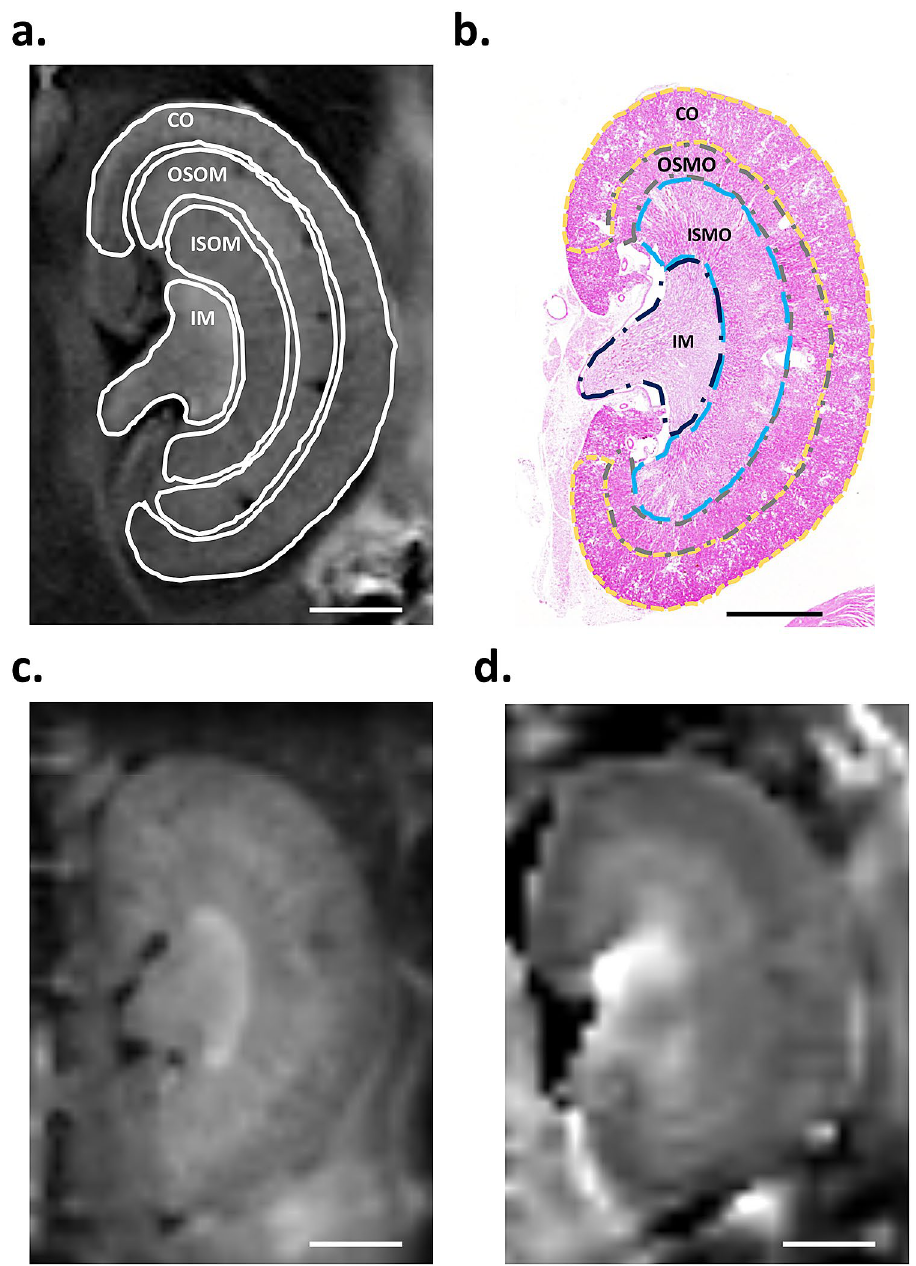
Figure 1. Morphological MR imaging of mouse kidney. (a) Coronal T2-weighted imaging, (b) the H&E staining of kidney, (c) b0 imaging, and (d) ADC mapping imaging form diffusion weighted imaging in a WT mouse. Renal architecture would be classified in renal cortex (CO), outer stripe of the outer medulla (OSOM), inner stripe of the outer medulla (ISOM), and inner medulla (IM) with H&E staining and T2-weight imaging. (The scale bar = 2000